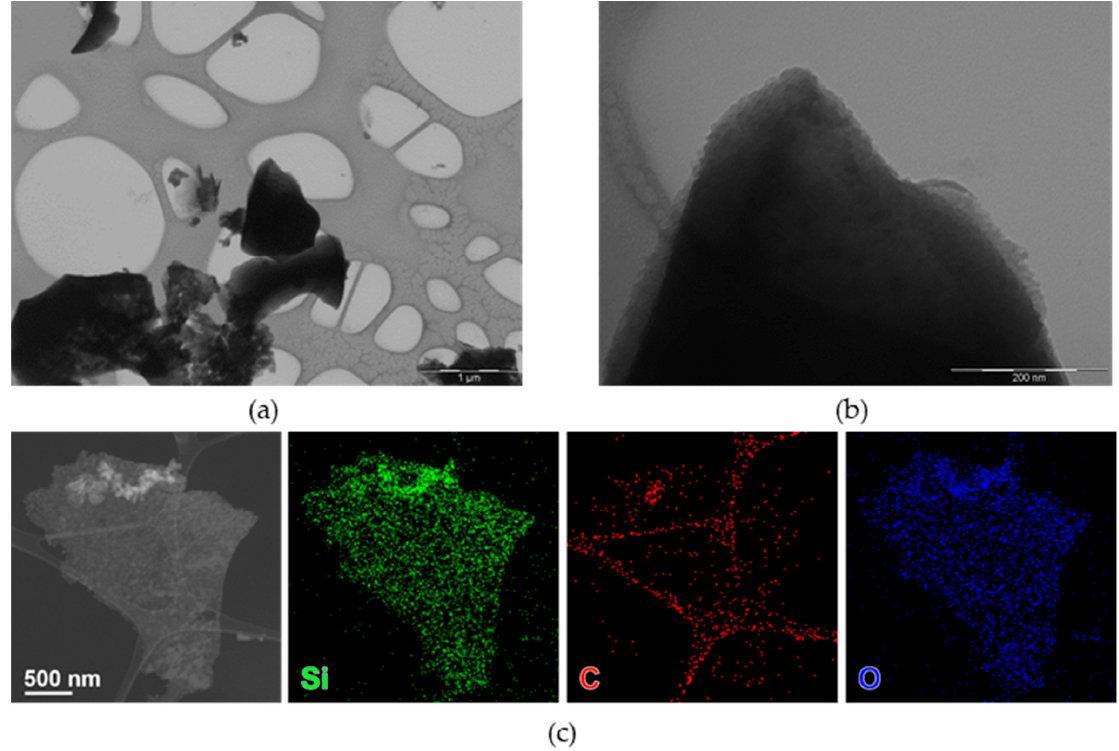
Figure 1. Bright-field TEM (BF-TEM) images of nC-RHA@SiO 2 at different magnifications: ( a ) 25,000 magnification and ( b ) 200,000 magnification. HAADF-STEM images ( c ) of an aggregate of nanoparticles of nC-RHA@SiO 2 , partly suspended on a hole in the carbon support film, and corresponding STEM-EDS maps for Si (green), O (blue), and C (red). A similar elemental distribution is observed for CDQ-RHA@SiO 2 , where the relative amount of C is increased compared to the sample nC-RHA@SiO 2 (Figure S3 and Table S1, Supplementary Material), and a closer look shows that each of the particles consists of a core of oxidized silicon ( ≈ 10 nm diameter) coated by a thin ( ≈ 3 nm thick) carbonaceous layer (Figure 2). High-resolution TEM analysis (not reported here) shows that the particles are amorphous.